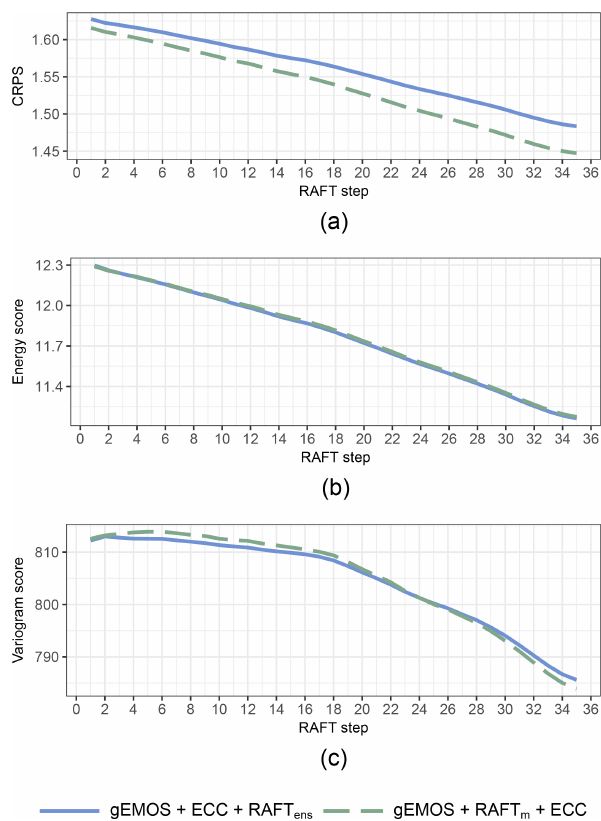
Figure 7. Mean CRPS, energy score and variogram score for every step in the RAFT m and RAFT ens process. Scores are averaged over all lead times, sites and model